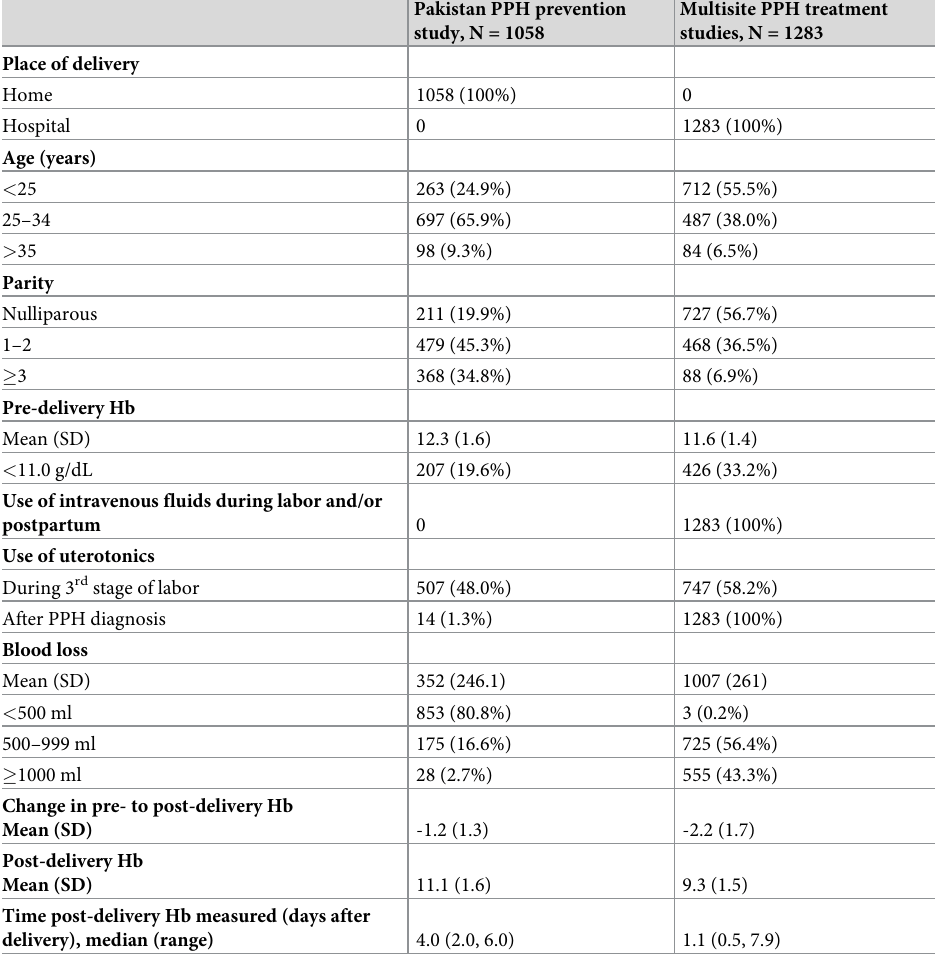
Table 1. Participant characteristics in the Pakistan postpartum hemorrhage (PPH) prevention study and the mul- tisite PPH treatment studies �